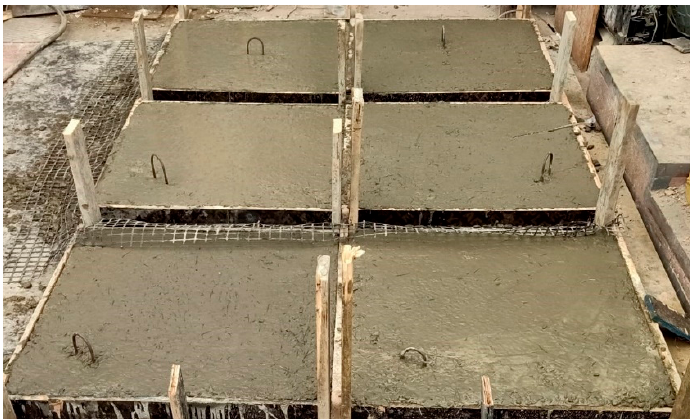
Figure 2. Concrete slabs.